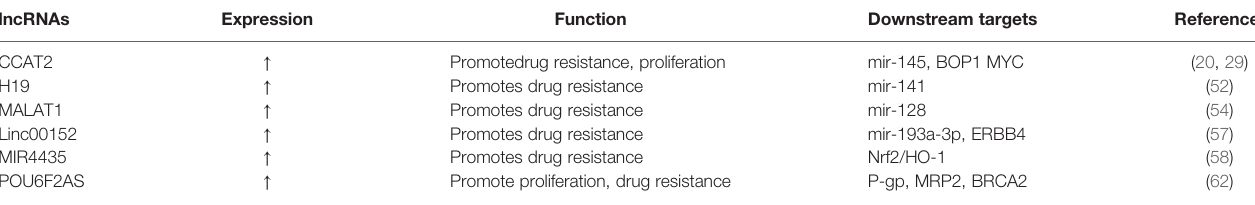
TABLE 2 | LncRNAs in CRC cell drug resistance.